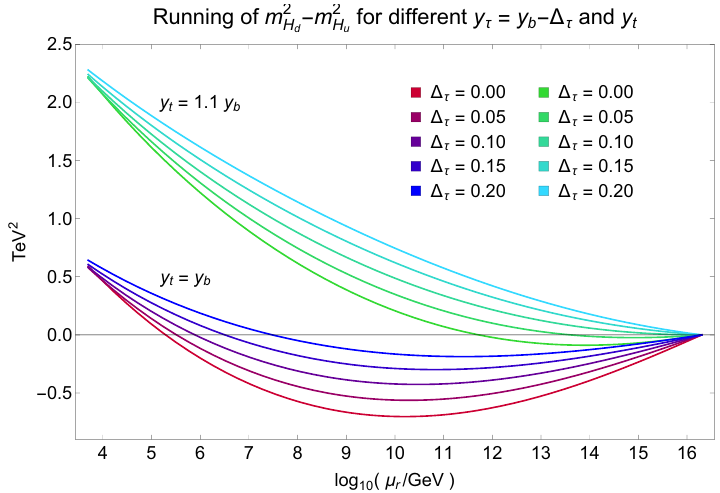
Figure 5 . The RGE running of m 2 (cid:0) m 2 for di(cid:11)erent deformations of b - (cid:28) uni(cid:12)action, i.e. values H d H u of y (cid:28) = y b (cid:0) (cid:1) (cid:28) . There are two sets of trajectories: the red-to-blue trajectories are for y t = y b ( t - b uni(cid:12)cation), while the green-to-cyan trajectories are for the case y t = 1 : 1 y b . All other quantities are the same as in the example point (3.11){(3.20).